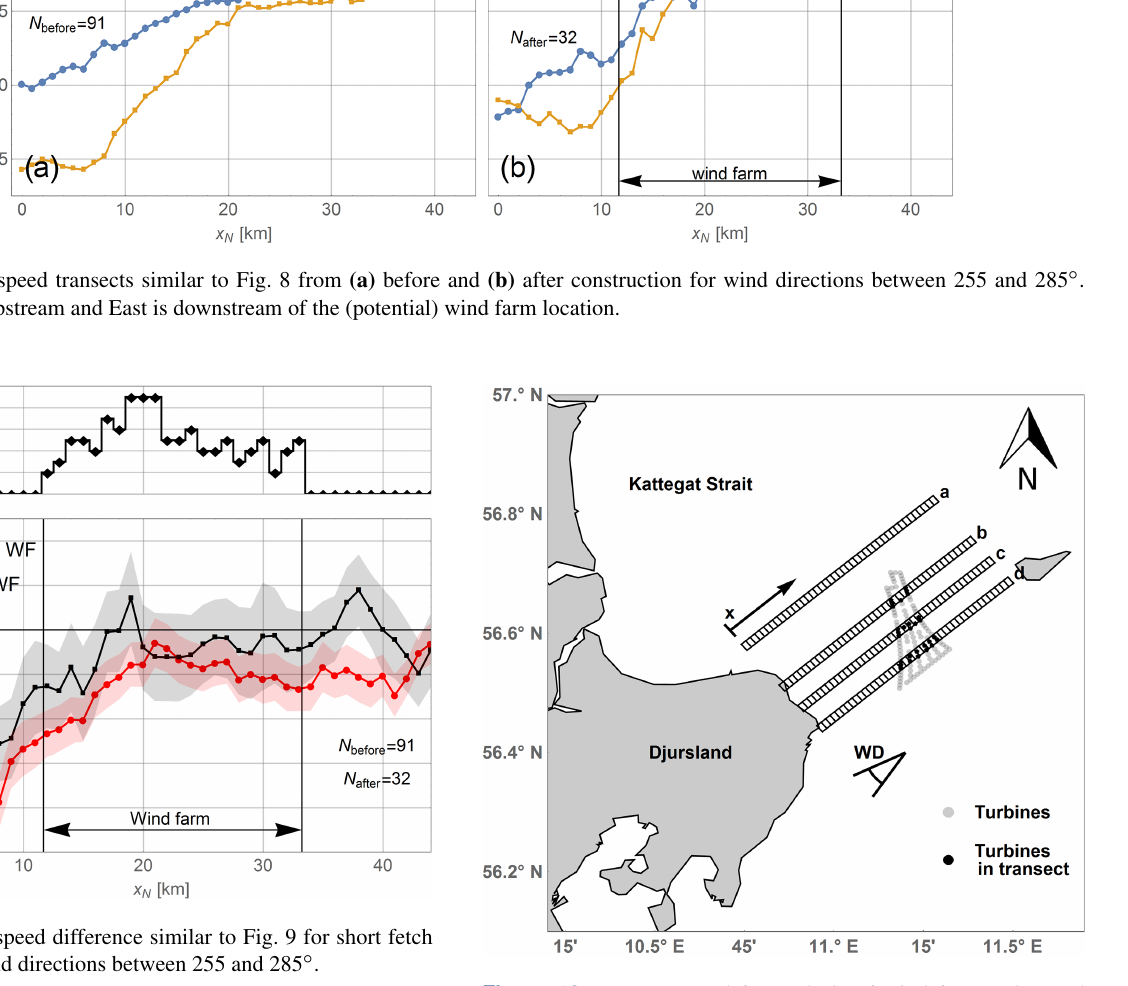
Figure 12. Transects used for analysis of wind farm wakes and coastal gradients. Origin and direction of coordinate x , and the wind direction range (WD) used for the selection of satellite scenes are